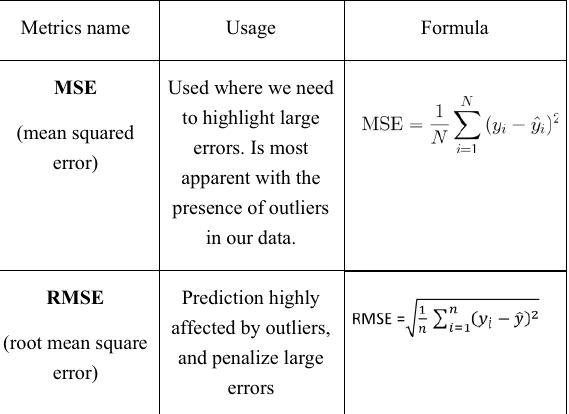
Table 4 . Evaluation Metrics